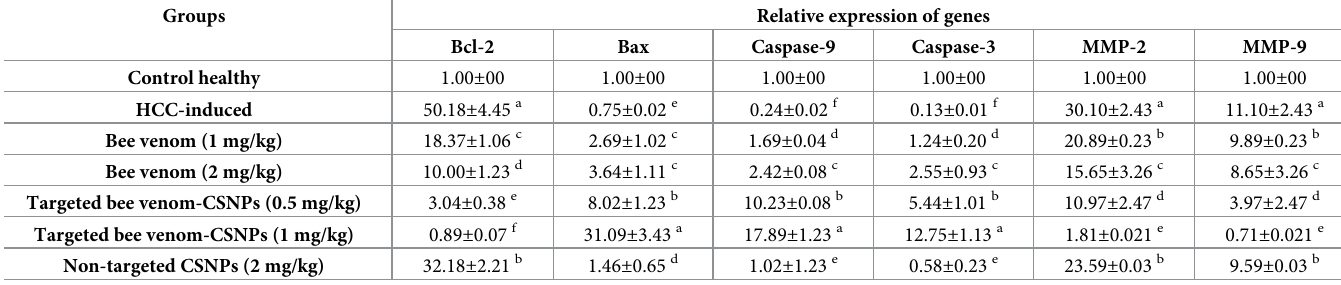
Table 5. Effect of targeted bee venom-CSNPs and native bee venom on Bcl-2, Bax, caspase 9, caspase 3, MMP-9, and MMP-2 genes expression. Groups